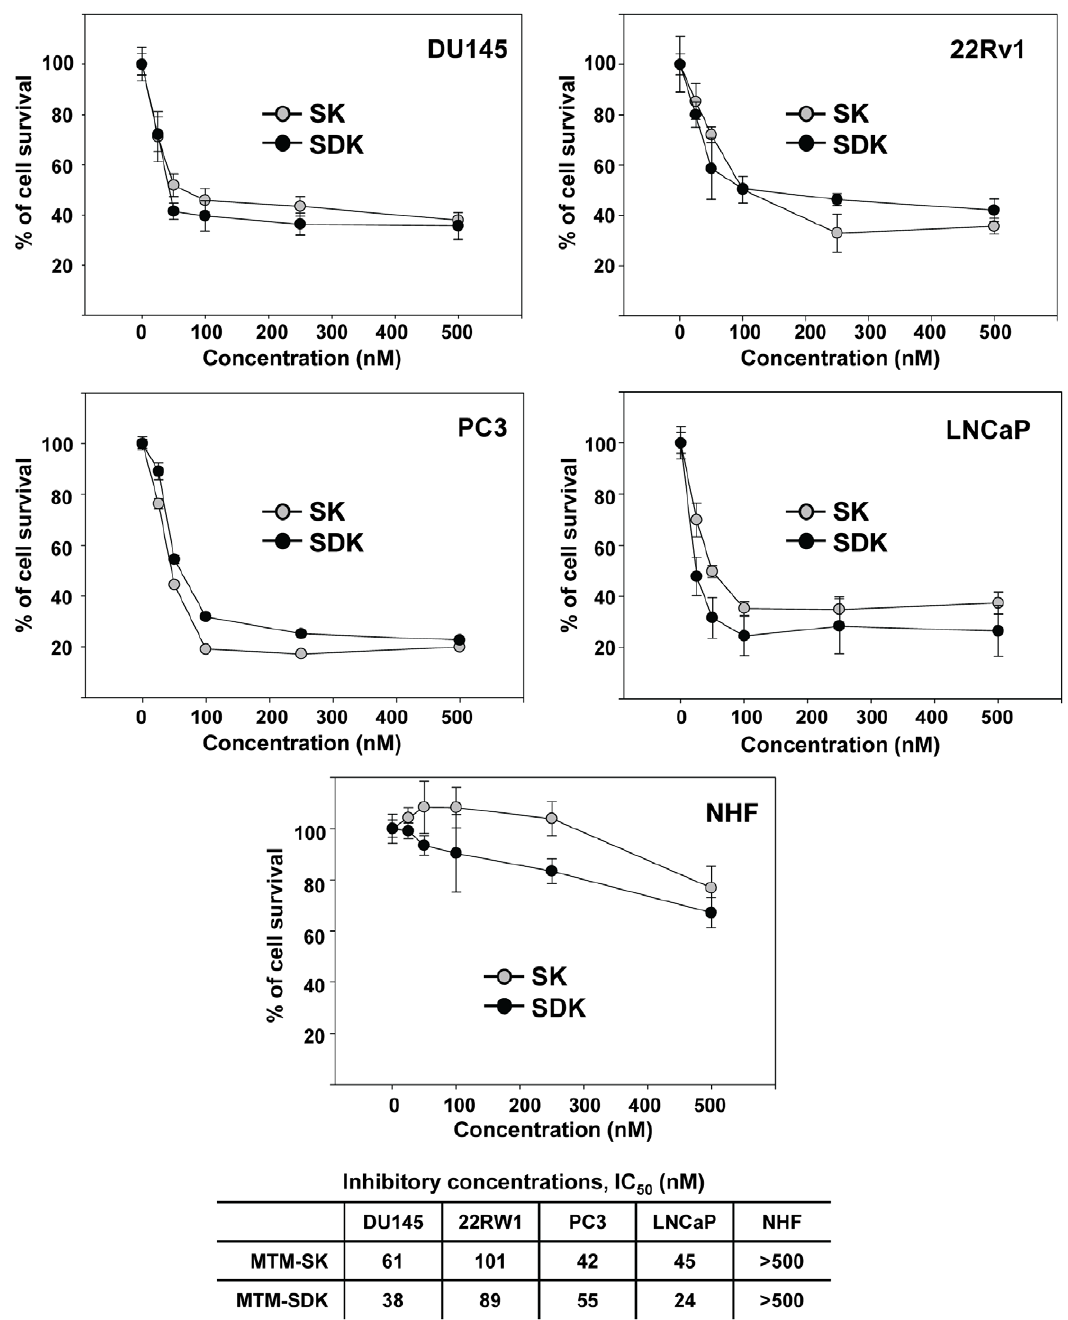
Figure 2. Antiproliferative effects of MTM-SDK and MTM-SK in prostate cancer cells invitro . Prostate cancer cells (DU145, 22Rv1, PC3 and LNCaP) and primary cultures of normal human fibroblasts (NHF) were incubated with the compounds for 72 h. Cell viability was measured by the colorimetric MTT assay. Data are presented as mean 6 SD of triplicate samples of 3 independent experiments. IC 50 for each cell type are reported in the bottom panel.